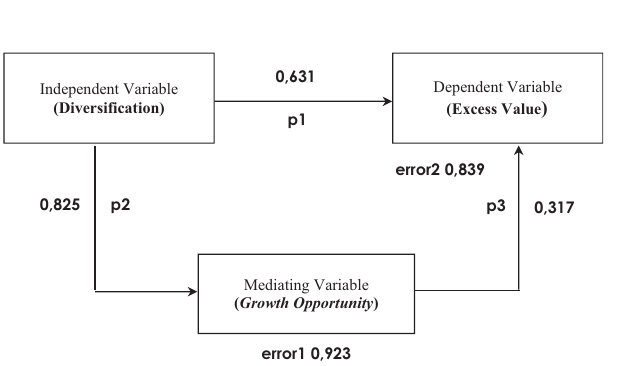
Table 4. Regression analysis of the mediating role of growth opportunity on the diversification – value relationship [estimated based on Eqn 4]